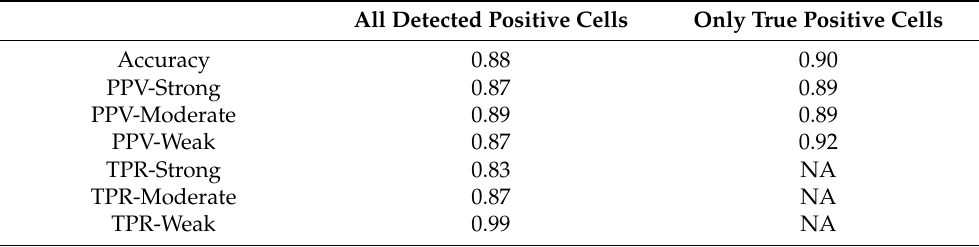
Table 7. Accuracy, PPV, and TPR for WMS